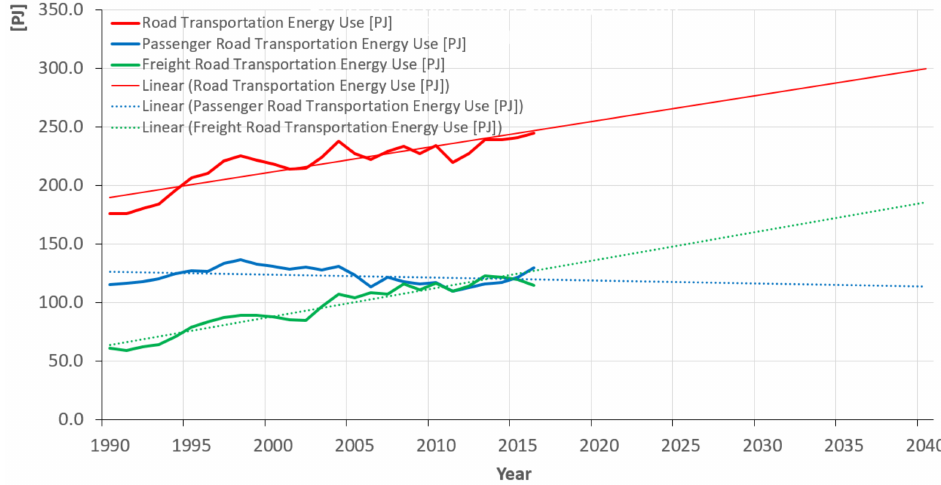
Figure 1. B.C. Road transportation energy use, data from [33].